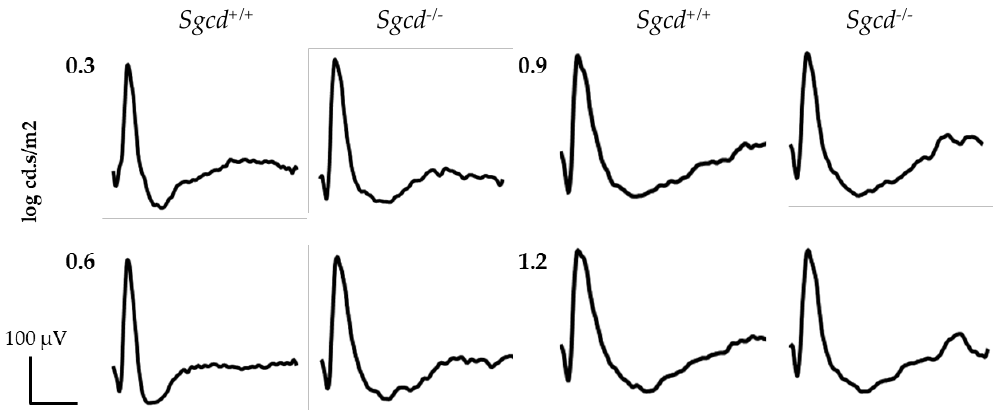
Figure 4. Electroretinographic scotopic responses in three-month-old Sgcd −/− and Sgcd +/+ mice at different light intensities after dark adaptation.